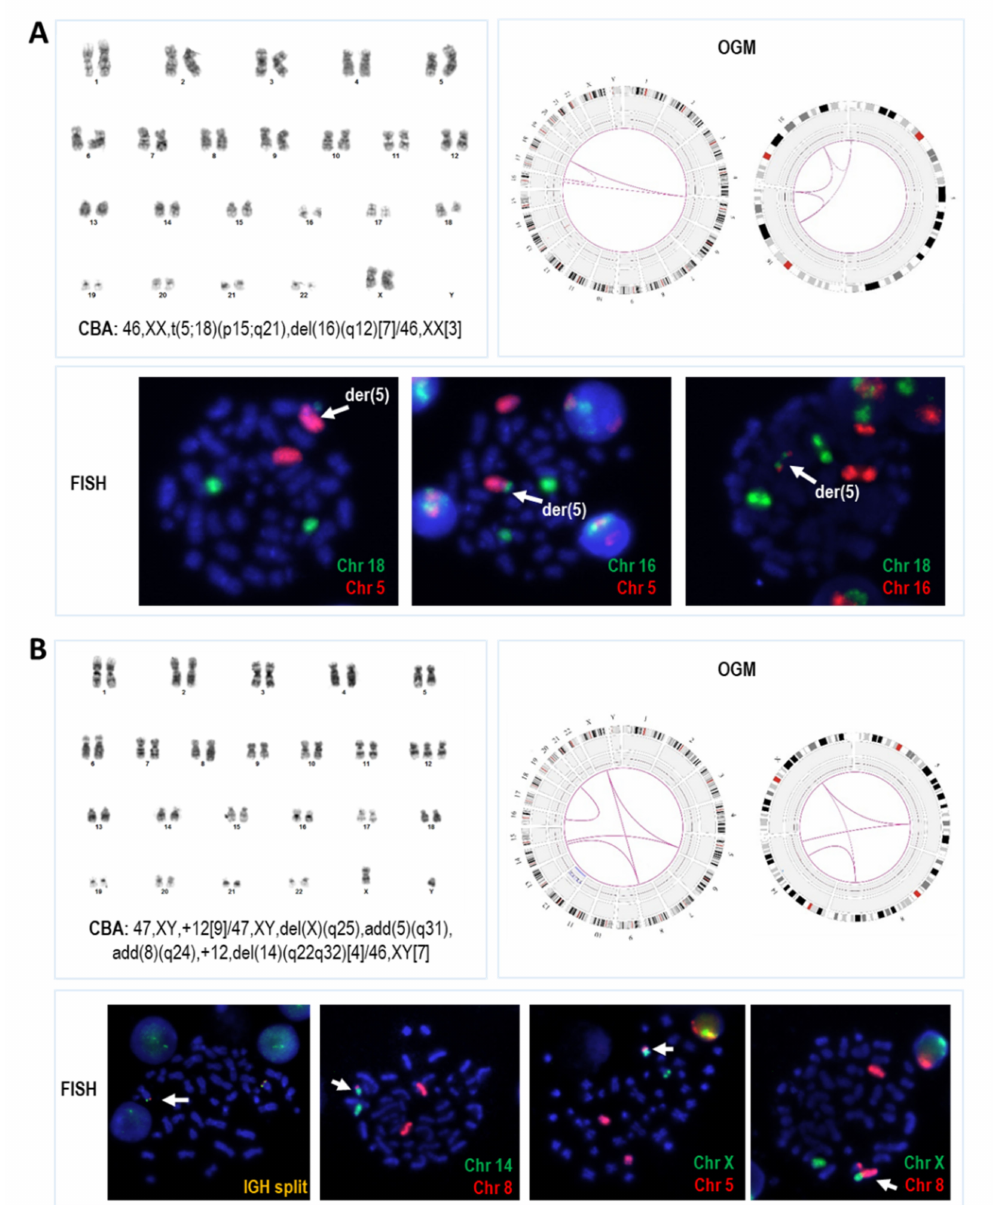
Figure 3. Examples of cases in which OGM revealed that abnormalities apparently well-described by CBA were more complex than initially assumed. ( A ) Patient #24 showed an abnormal kary- otype described as containing a t(5;18)(p15;q21) and a del(16)(q12). Whole-genome Circos plot and Circos plot from chromosomes 5, 16 and 18 obtained by OGM revealed that the initially reported abnormalities were a three-way translocation between these chromosomes. OGM results were con- firmed by WCP, in which material from both chromosomes 16 and 18 was detected in the der(5) chromosome; ( B ) The karyotype defined in patient #CK11 contained two deletions [del(X)(q25) and del(14)(q22q32)] and additional material of unknown origin at chromosomes 5 and 8 [add(5)(q31) and add(8)(q24)]. Circos plots show the four translocations identified by OGM that shared breakpoints on chromosomes X, 5 and 8, and two breakpoints on chromosome 14 were located at the start and end coordinates from a known CNV loss identified by CMA. FISH analysis allowed their validation and karyotype reinterpretation. The corrected ISCN formula for this abnormal clone was finally defined as 47,XY,der(X)t(X;5)(q22.1;q32),der(5)t(5;14)(q32;q32.2),der(8)t(X;8)(q22.1;q23.3),+12,der(14)t(8;14)